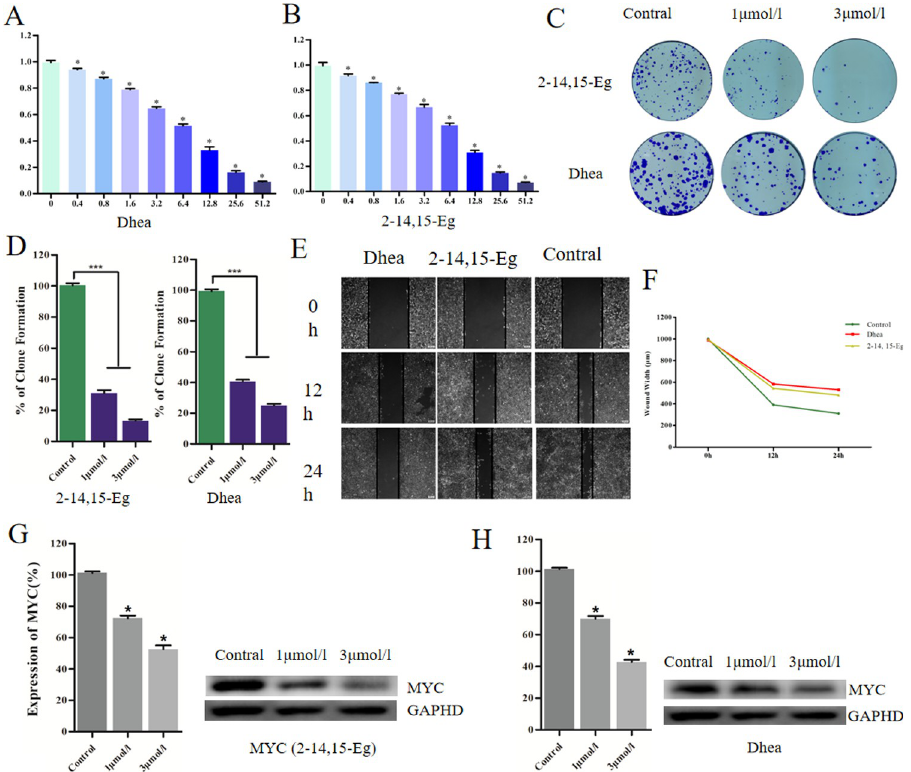
Fig 5. The anti-CCA effects of Dhea and 2–14,15-Eg were due to its inhibition of MYC (A) Cellular viability of cholangiocarcinoma cells treated with Dhea and (B) 2–14,15-Eg. (C) (D) Colony formation assay results of Dhea and 2–14,15-Eg anti-proliferative effects in HuCCT1 cells. (E) (F) Dhea and 2–14,15-Eg suppressing the migration of osteosarcoma cells in the scratch assay. (G) (H) Results of western blot of MYC.